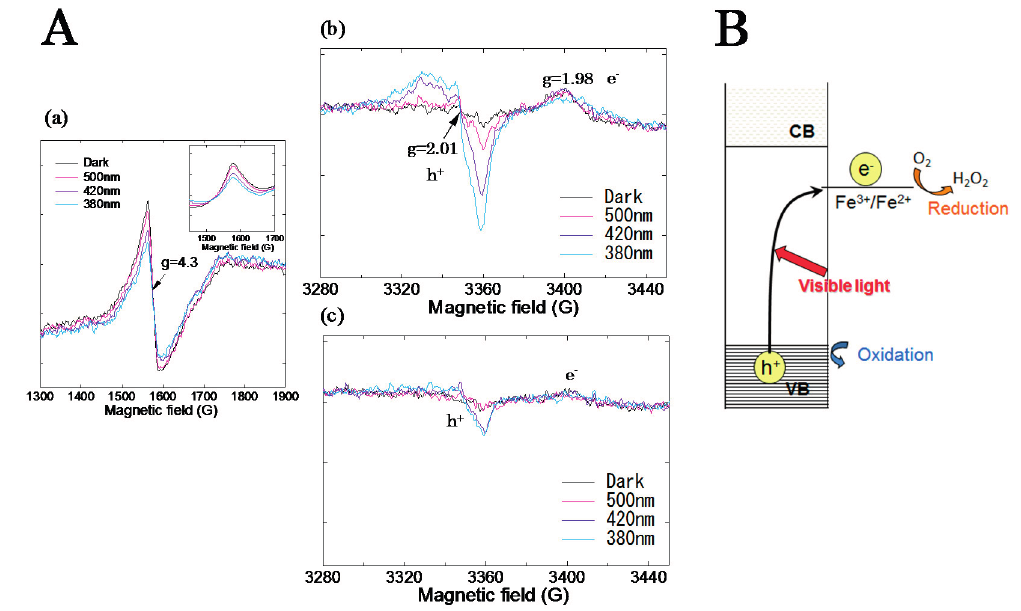
Figure 4. ( A ) ESR spectra of ( a ) Fe 3+ and ( b ) holes for Fe/TiO 2 and ( c ) holes for TiO 2 before and after light irradiation with different wavelengths; ( B ) Photocatalytic reaction mechanism for Fe/TiO 2 under visible light irradiation. Reprinted with permission from [23]. © 2012 American Chemical